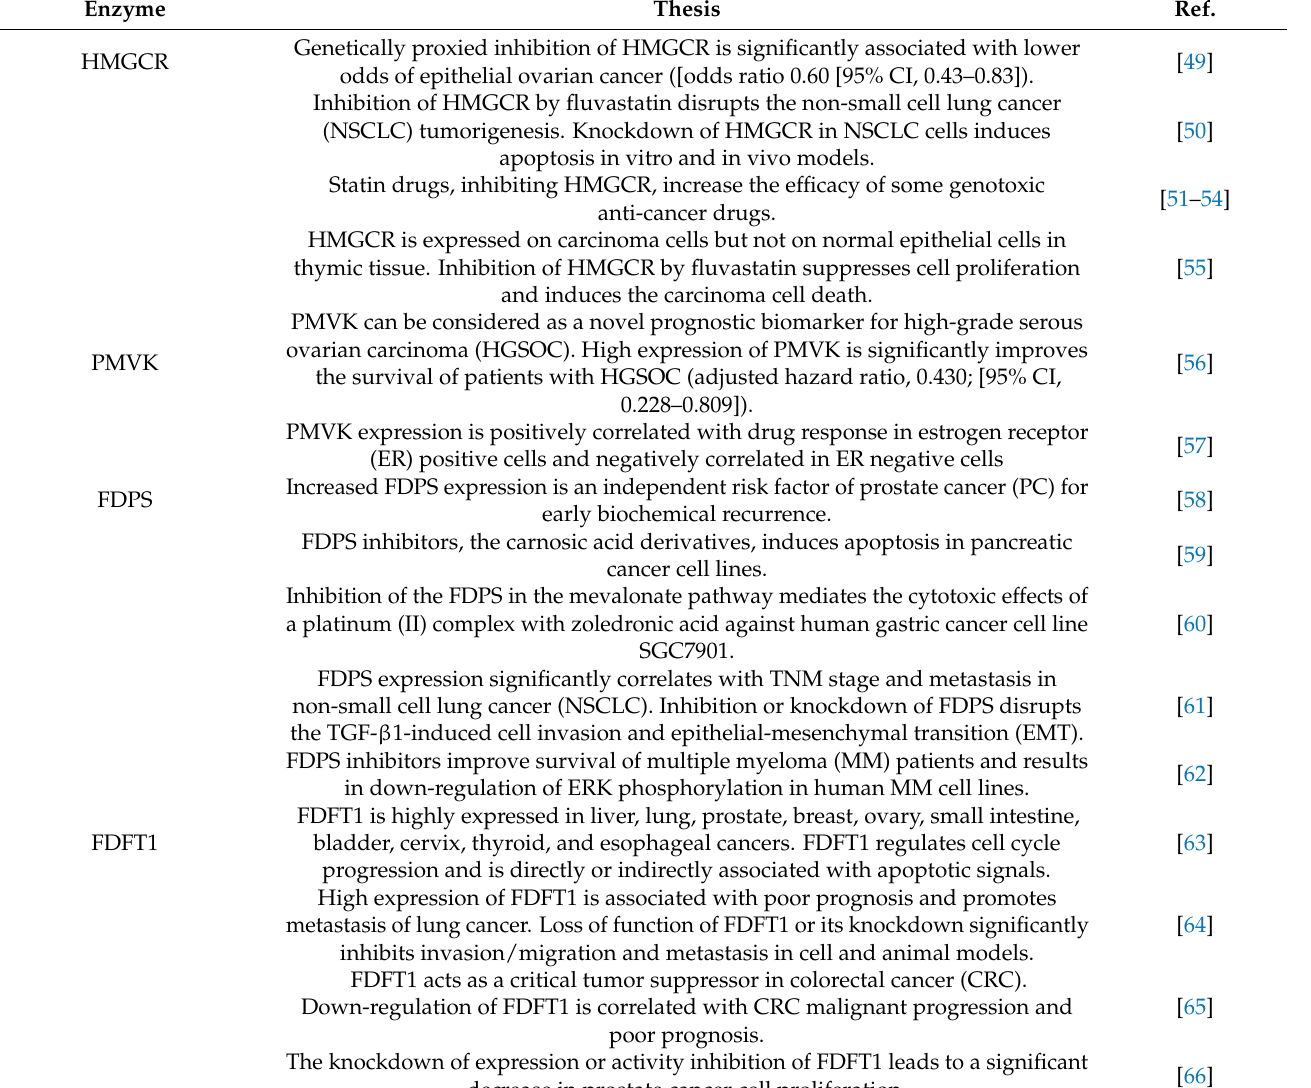
Table 2. Associations between cholesterol synthesis enzymes and